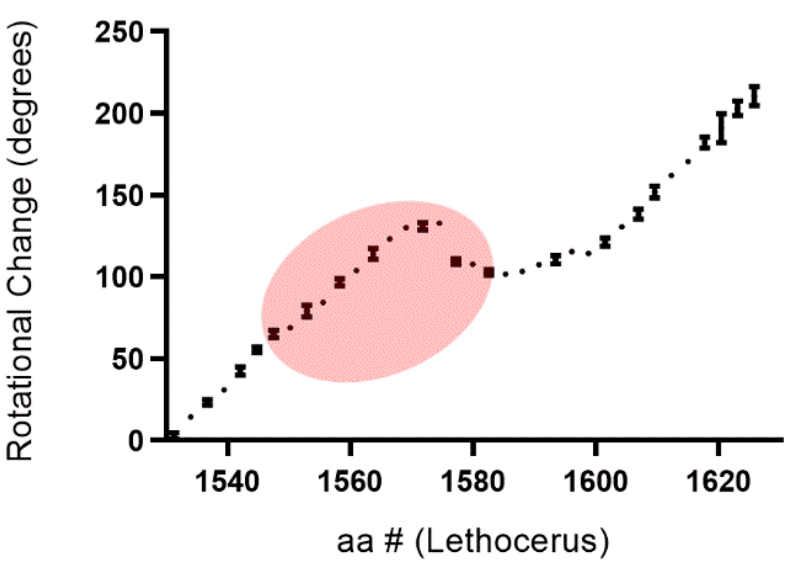
Figure 3. M-ward helical rotation of the coiled-coil from G1528-A1628 where the change in angle represents rotational change between frames. Each point is averaged across three dimers within the same layer ± SD. The points within red shading is the area over which the red density is contacting the myosin dimer.